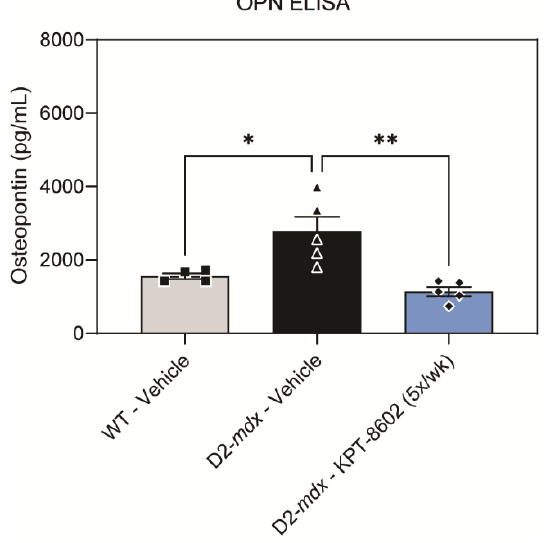
Figure 4. KPT − 8602 reduces osteopontin serum levels in D2- mdx mice. Osteopontin (OPN) in circulating serum levels was assessed by ELISA assay. KPT − 8602 (5x/week) treatment significantly reduced osteopontin levels compared to vehicle-treated D2- mdx , demonstrating levels comparable to WT mice (data is presented as mean ± SEM, n = 4–5 mice per cohort; * p < 0.05, ** p < 0.01; one-way ANOVA with Tukey’s HSD test).